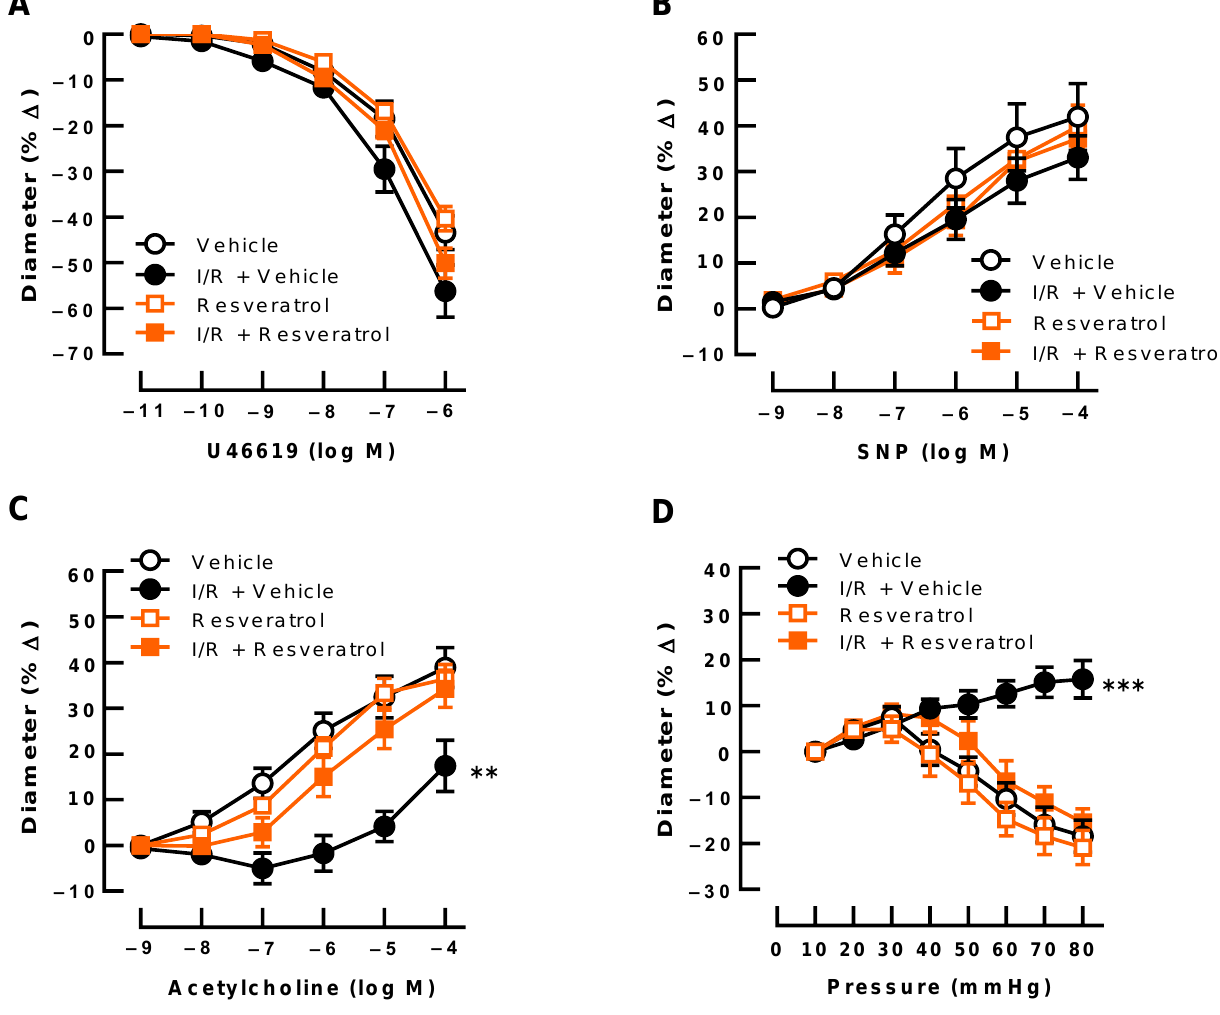
Figure 2. Responses of retinal arterioles to vasoactive substances. ( A ) The thromboxane A 2 receptor agonist, U46619, produced concentration-dependent vasoconstriction responses in retinal arterioles that were similar in all groups. ( B ) Similarly, responses to the endothelium-independent vasodilator, sodium nitroprusside (SNP), did not differ between the four groups. In contrast, retinal arterioles from vehicle-treated eyes subjected to I/R displayed impaired endothelium-dependent vasodilator responses to acetylcholine ( C ) and virtually abolished responses to changes of perfusion pressure ( D ), which, however, were retained by treatment with resveratrol. Values are expressed as means ± SE (*** p < 0.001; ** p < 0.01; I/R + vehicle versus all other groups; n = 8 per